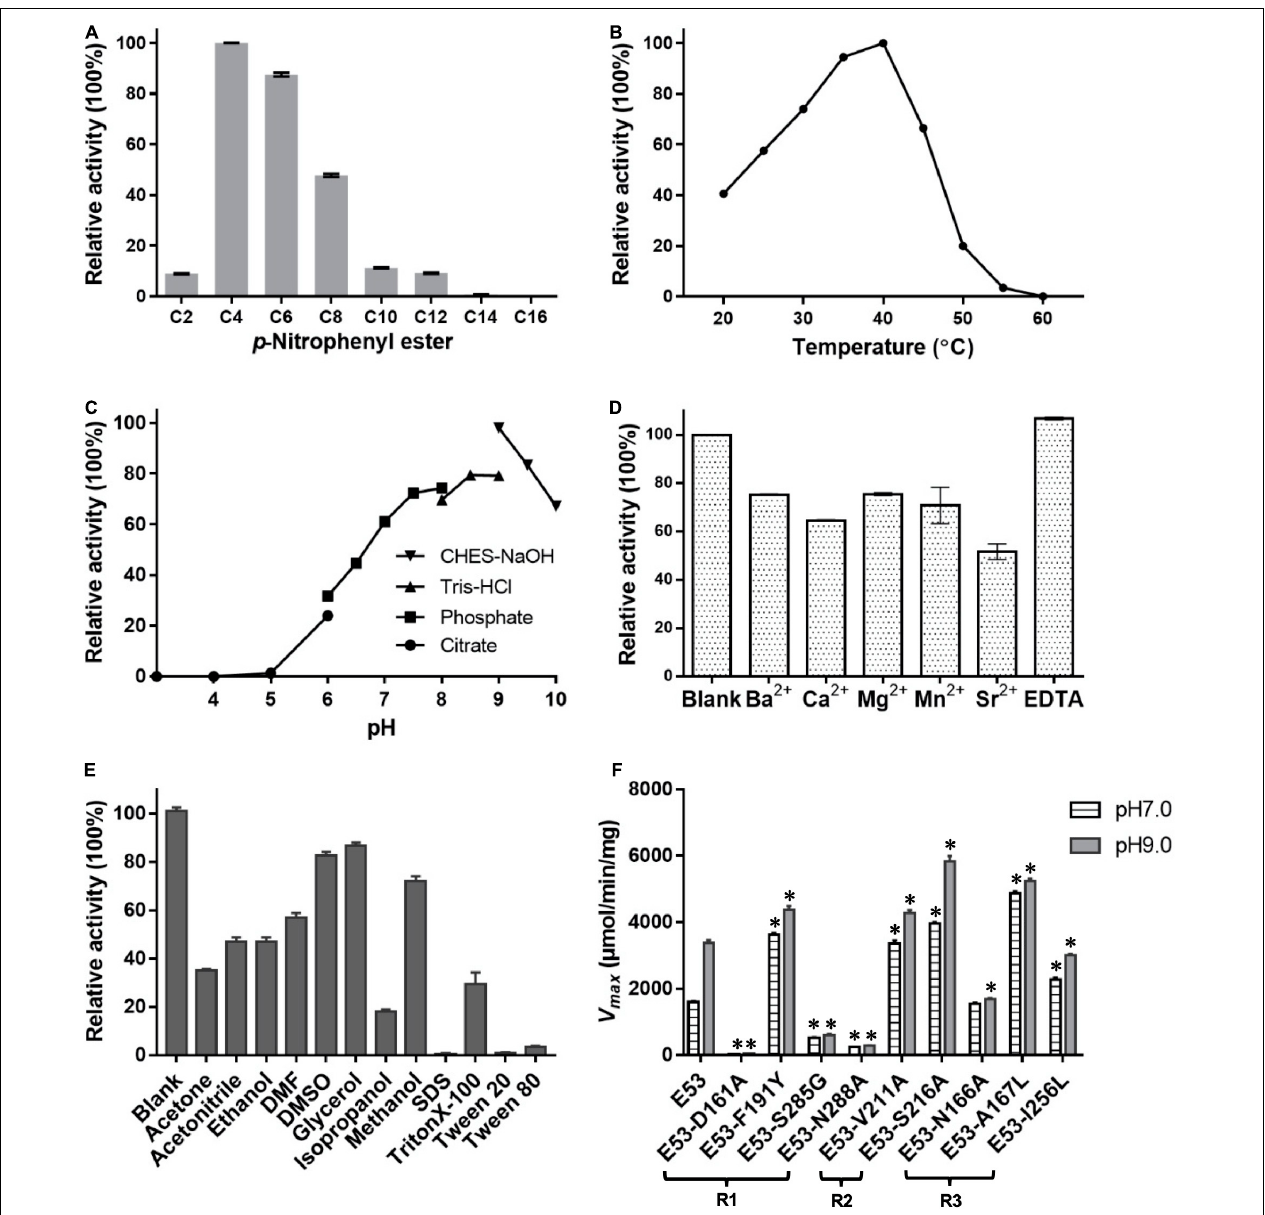
FIGURE 2 | Enzymatic features of E53 and the variants. (A) Substrate specificities of E53. The catalytic activity was measured under pH 9.0 and 40 ◦ C. The catalytic activity with the C4 substrate was defined as 100% activity. (B) Effect of temperature on the enzyme activity: the optimum temperature was 40 ◦ C. The C4 substrate was used for measurements (B–F) . (C) Effect of pH value on the enzyme activity: optimum pH was in the range of 8.5–9.5. (D) Tolerance of E53 on EDTA and different divalent cations. The reaction without ions was used as a control. (E) Effects of organic solvents on the enzymatic activity of E53. The reaction without any organic solvent was used as a control. (F) Maximum velocity ( V max ) of E53 and its variants. The catalytic assay was under pH 7.0 and pH 9.0 conditions, 40 ◦ C. The data are shown as mean ± SD ( n = 3). ∗ Represents a significant difference from the WT E53 in the same conditions ( t -test, p < 0.05). For some points, the error bars would be shorter than the height of the